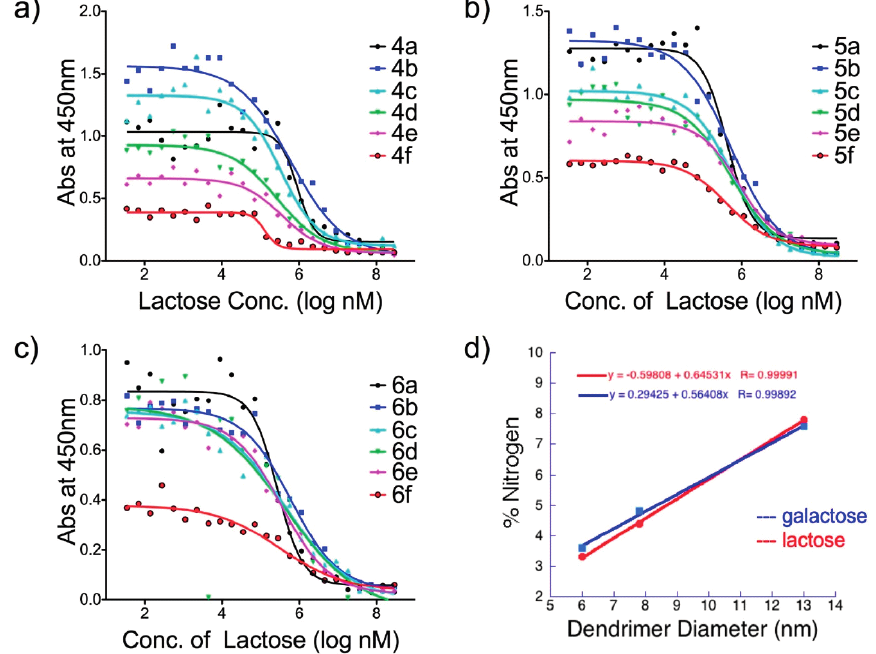
Figure 4. ELISA binding curves with ( a ) 4a – f ; ( b ) 5a – f ; ( c ) 6a – f and ( d ) XPS results of dendrimer diameter vs . nitrogen % for compounds 4a , 5a , 6a and 4f , 5f , 6f . ELISA binding curves and surface characterization information for